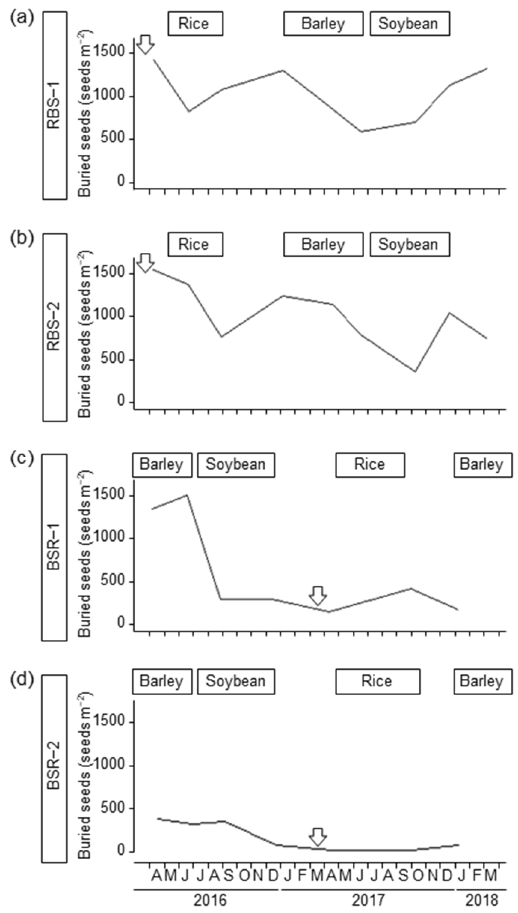
Figure 4. Numbers of buried seeds of entireleaf morning glory in the field margins. ( a ) RBS-1; ( b ) RBS-2; ( c ) BSR-1; ( d ) BSR-2. Arrows, the time of levee plastering. RBS-1, rice–barley–soybean-1; RBS-2, rice–barley–soybean-2; BSR-1, barley–soybean–rice-1; BSR-2, barley–soybean–rice-2. Values are presented as mean. The horizontal axis shows the survey months (April 2016 to March